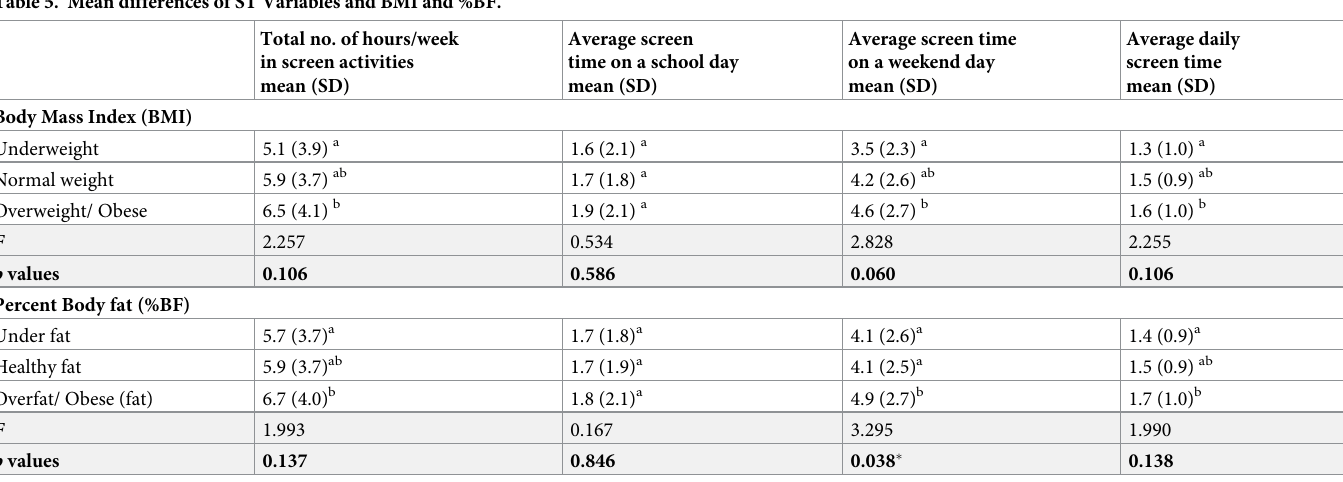
Table 5. Mean differences of ST Variables and BMI and